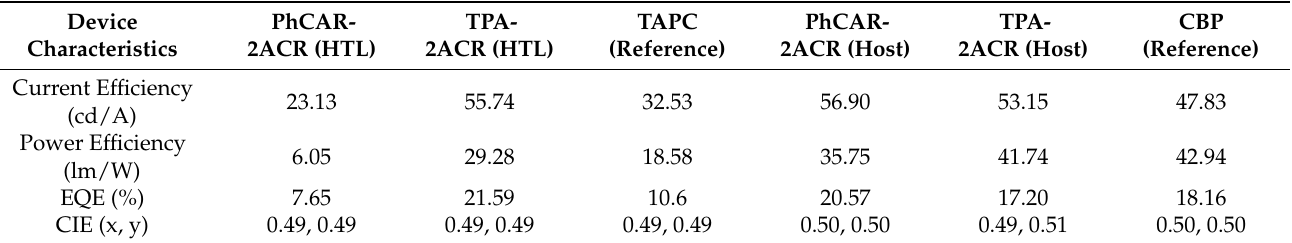
Table 2. Device characteristics of PhCAR-2ACR and TPA-2ACR-based phosphorescent devices with TAPC and CBP reference